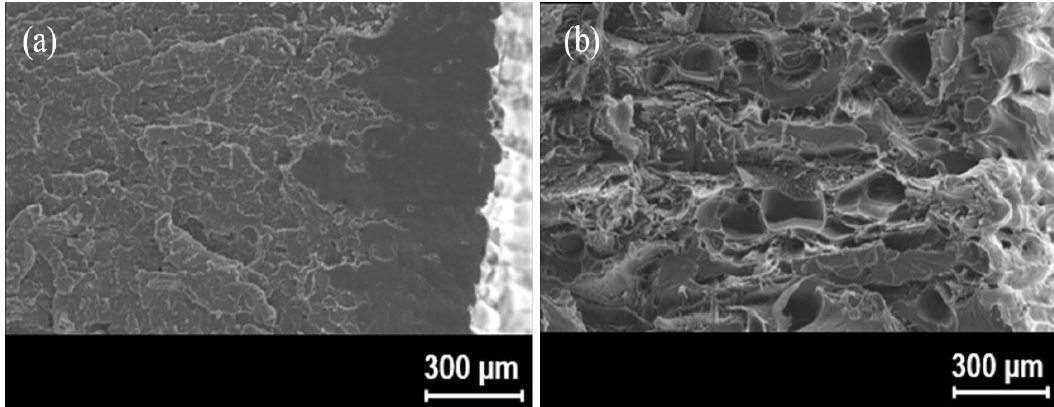
Figure 12. ( a ) ABS print cross-section with a layer thickness of 0.06 mm. ( b ) ABS cross-section with a layer thickness of 0.17 mm. The increased layer thickness caused many voids [53].